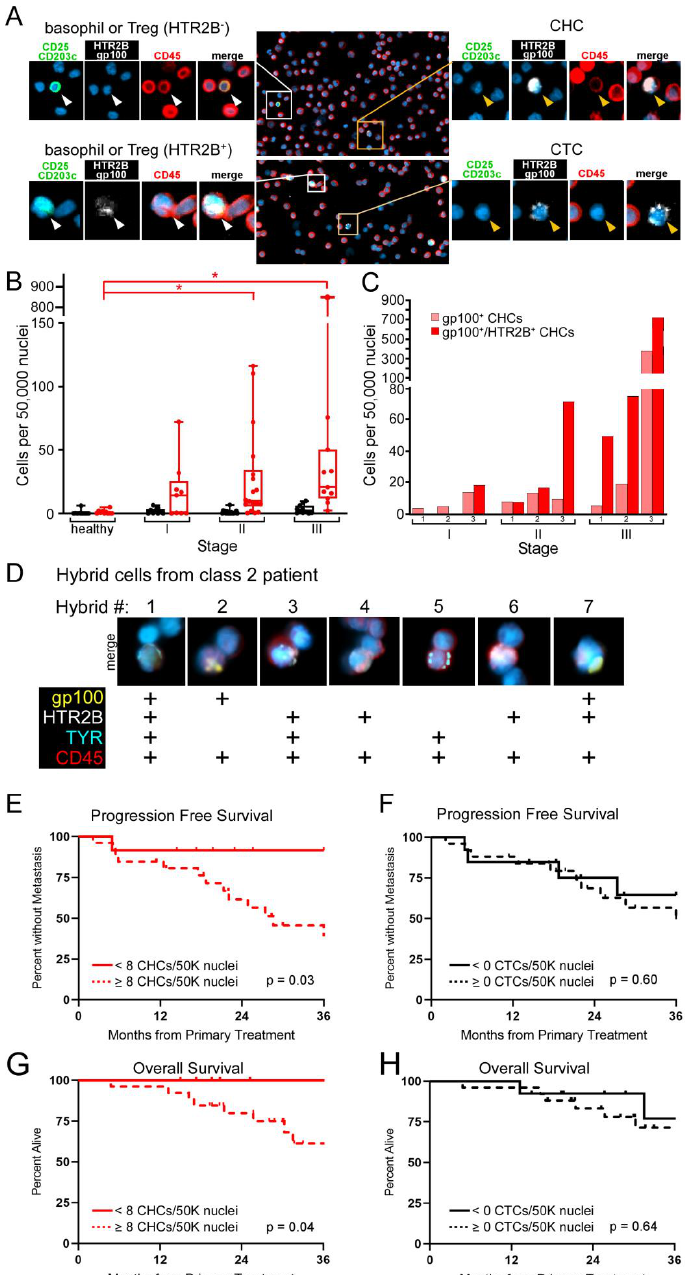
3 Figure 3. Circulating hybrid cells (CHCs) detected with an enhanced antibody cocktail correlate with progression free survival and overall survival. ( A ) Peripheral blood mononuclear cells stained with antibodies to gp100/HTR2B (white) and CD45 (red) facilitate identification of CHCs and circulating tumor cells (CTCs). CHCs are distinguished from basophils and T regulatory cells (Treg) based upon lack of expression of CD203c and CD25 (green), respectively. Higher magnification of boxed regions with individual antibody staining shown. ( B ) Enumerated CHCs and CTCs in healthy subjects and patients across stage. Asterisk indicates p < 0.05. ( C ) Levels of gp100 + CHCs and gp100 + /HTR2B + CHCs from three representative patients from each evaluated stage. ( D ) CHCs harboring heterogeneous protein expression identified in a class 2 patient. ( E , F ) High levels of CHCs correlate with progression free survival and overall survival, whereas there is no correlation for CTCs ( G , H